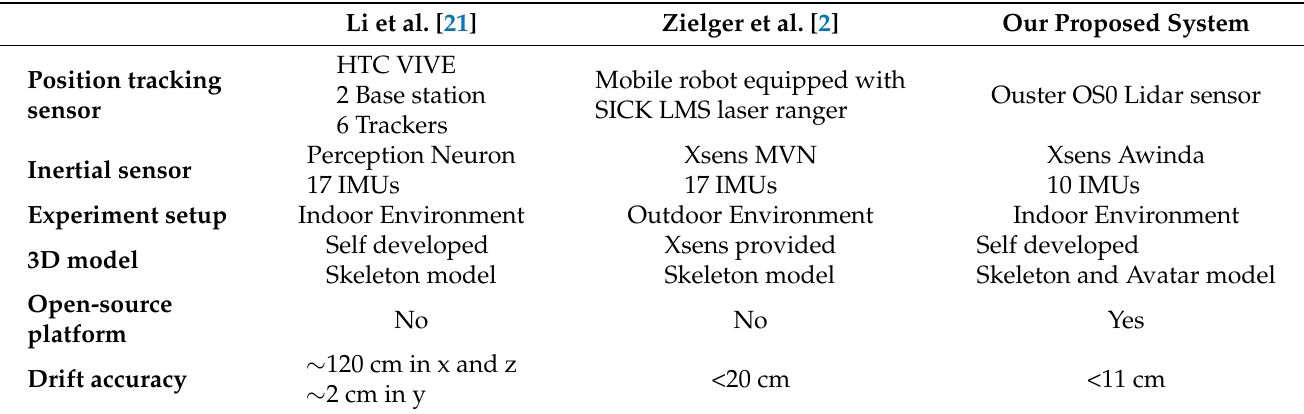
Figure 11. Human pose reconstruction on 3D avatar. Table 3. Comparison of human motion tracking system